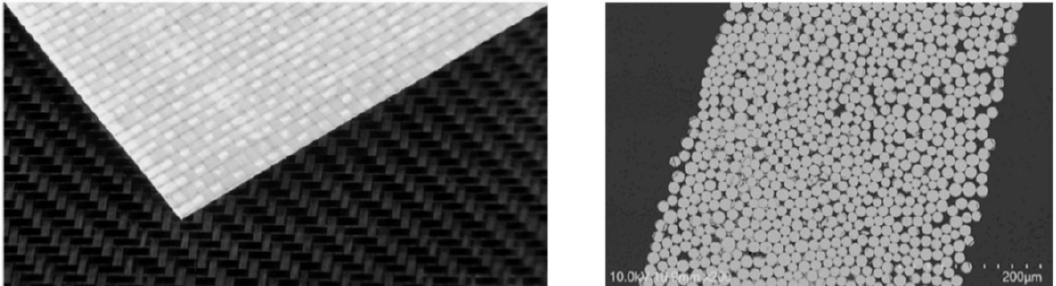
Figure 17. Left : Glass fiber and carbon fiber OS-6 series Nylon-6 organosheets. Right : Fully impreg- nated Nylon-6 organosheet [90].